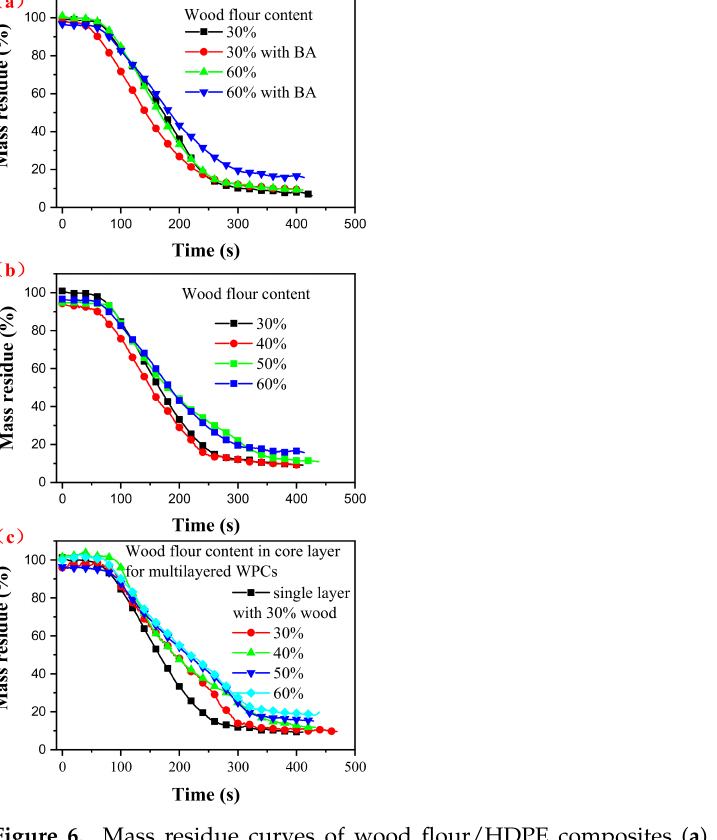
Figure 6. Mass residue curves of wood flour/HDPE composites ( a ), boric acid treated wood flour/HDPE composites ( b ), and multilayered wood flour/HDPE/PC composites ( c